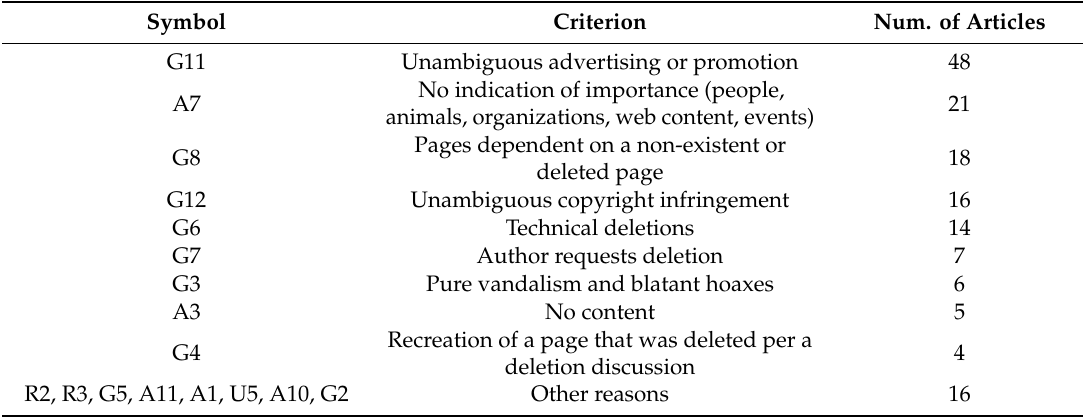
Table 3. Speedy deletions of crypto coin articles with the criterion of fast deletion